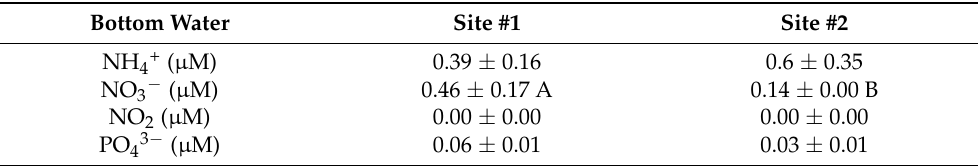
Table 1. Characterization of bottom seawater (mean values ± standard deviation). Significant differences between sites ( t -Student test) are indicated by capital letters. Bottom Water Site #1